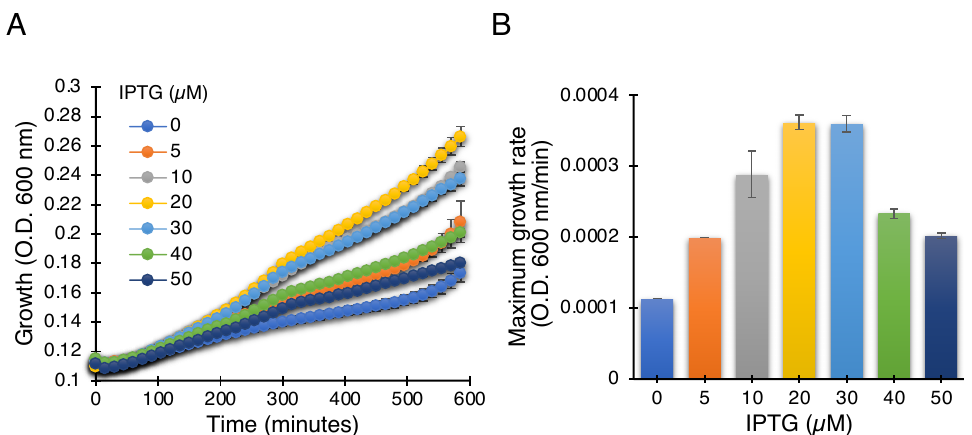
Figure 2. Positive genetic assay utilizing K + -uptake deficient bacteria, which are unable to grow on LB media without potassium supplement. Growth curves ( A ) and maximal growth rates ( B ) of K + -uptake deficient bacteria harboring the ZikV-M plasmid grown with different concentrations of IPTG, as noted.